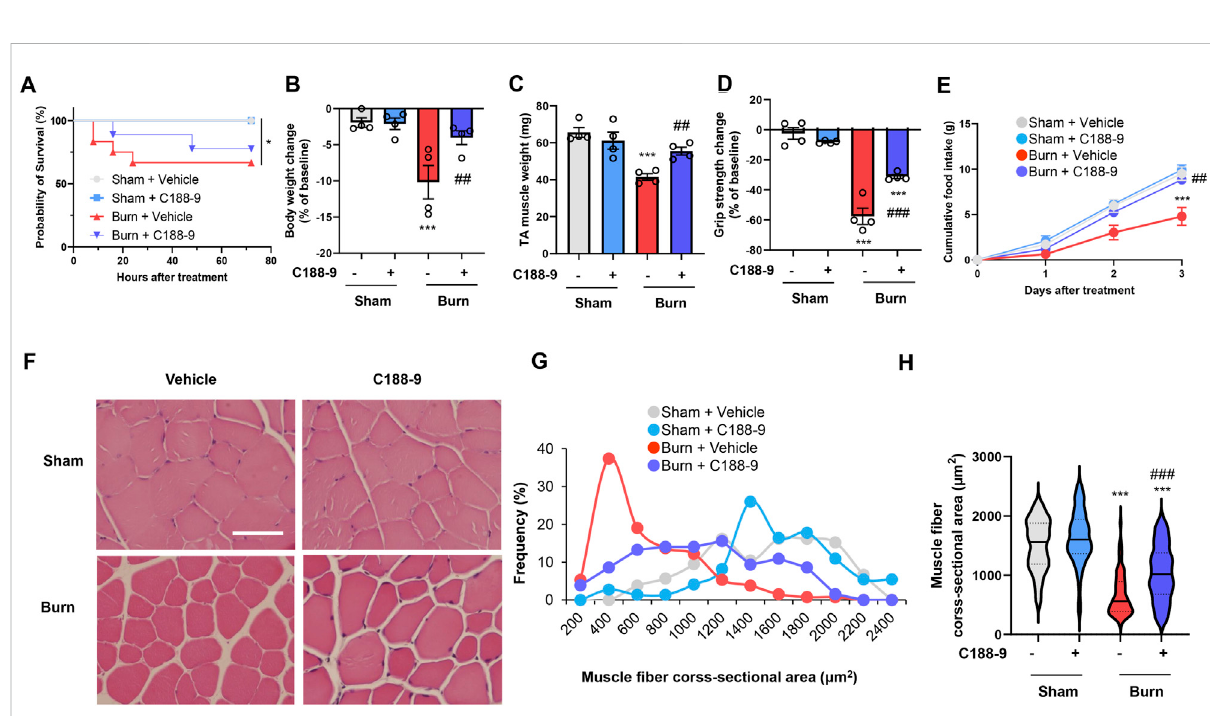
FIGURE 4 C188-9 reduces thermal burn-induced muscle atrophy and weakness in mice. Third-degree or sham burns were administered to wild-type C57BL/6 mice (12 – 16-week-old male mice) that were then ip injected with vehicle (5% wt/vol dextrose in distilled water containing 5% vol/vol DMSO)orC188-9(50 mg/kg)1 hlater.TheipinjectionofC188-9orvehiclewasrepeatedevery24 huntilsacri fi ce. (A) Cumulativesurvivalafterburn or sham-burn injury in mice given vehicle or C188-9. N = 9 – 11/group. * p < 0.05 by log rank test. After 3 days, mice were assessed for body